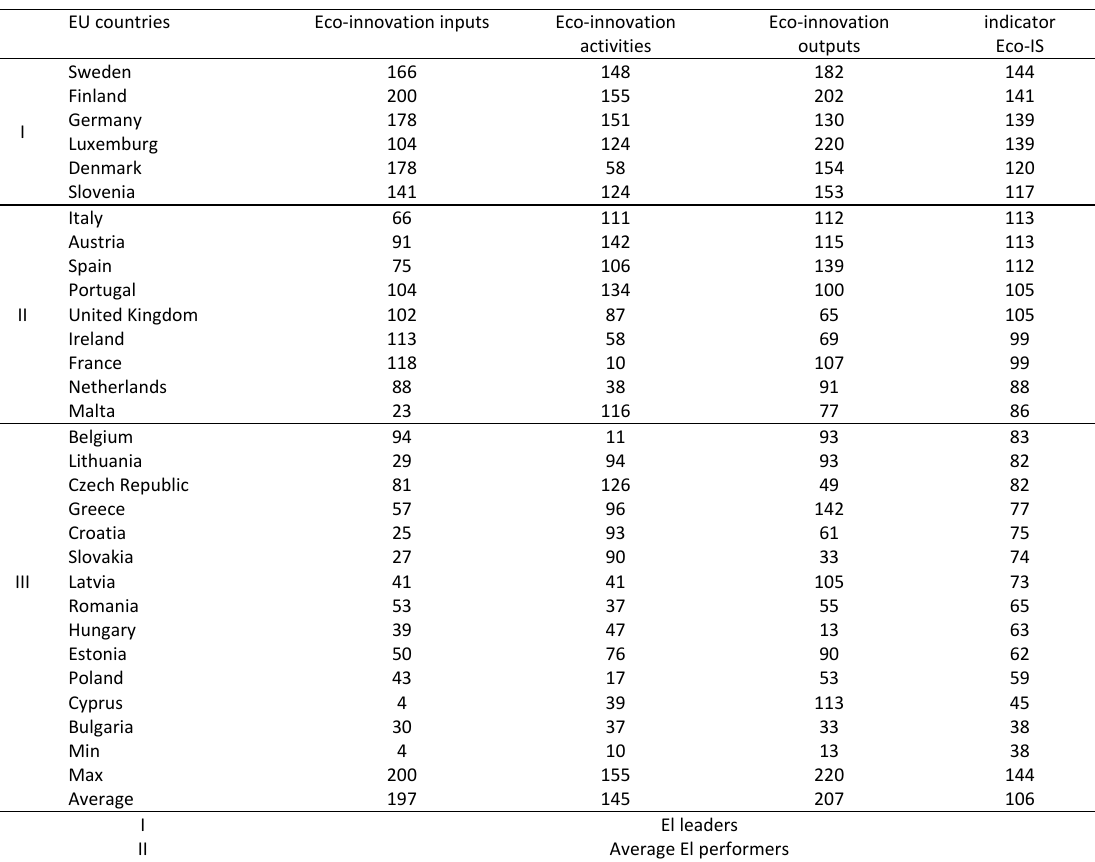
Table 1: Eco-innovation Scoreboard (Eco-IS) in EU countries in